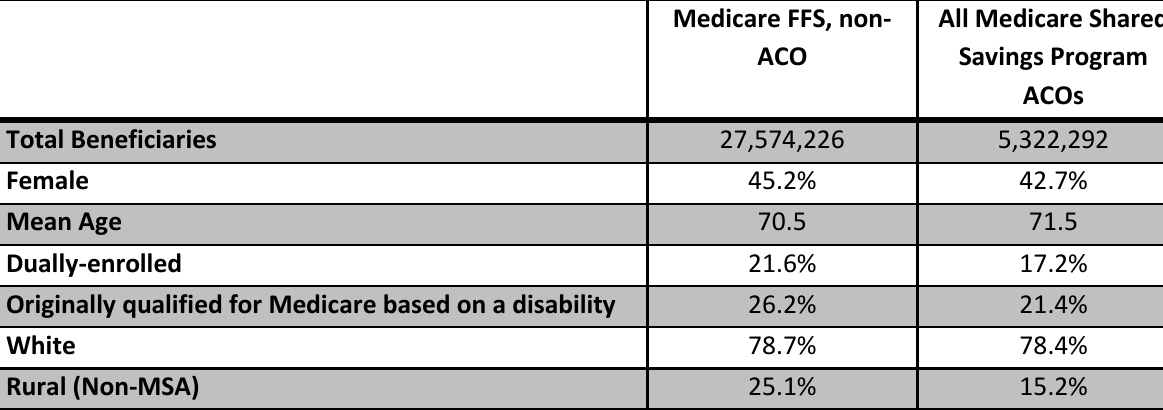
Table 9.1a: Patient Characteristics, ACO vs. Non-ACO (2014)